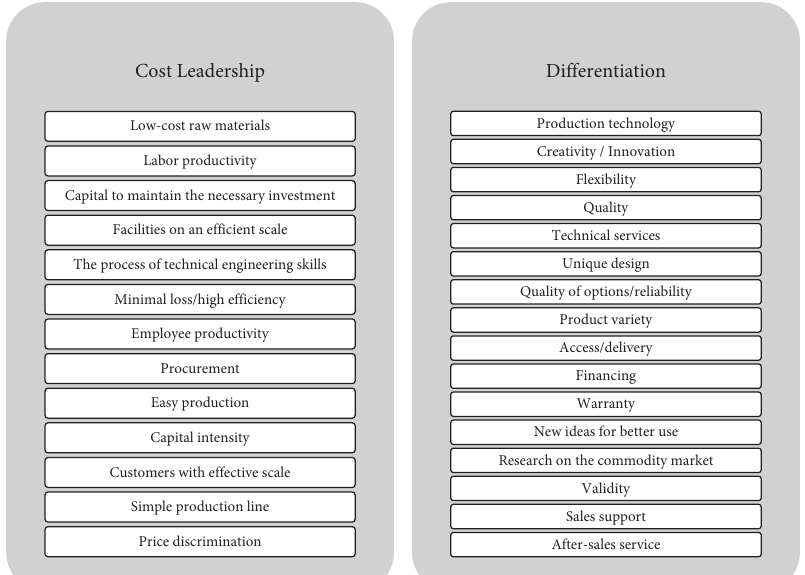
Figure 2: Cost leadership and differentiation strategy characteristics.